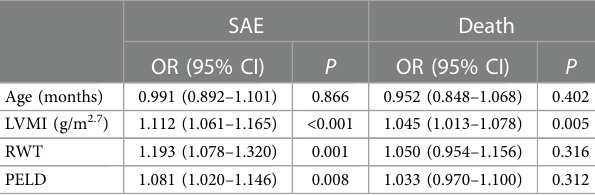
TABLE 2 Multivariate logistic regression analysis for SAE and death.